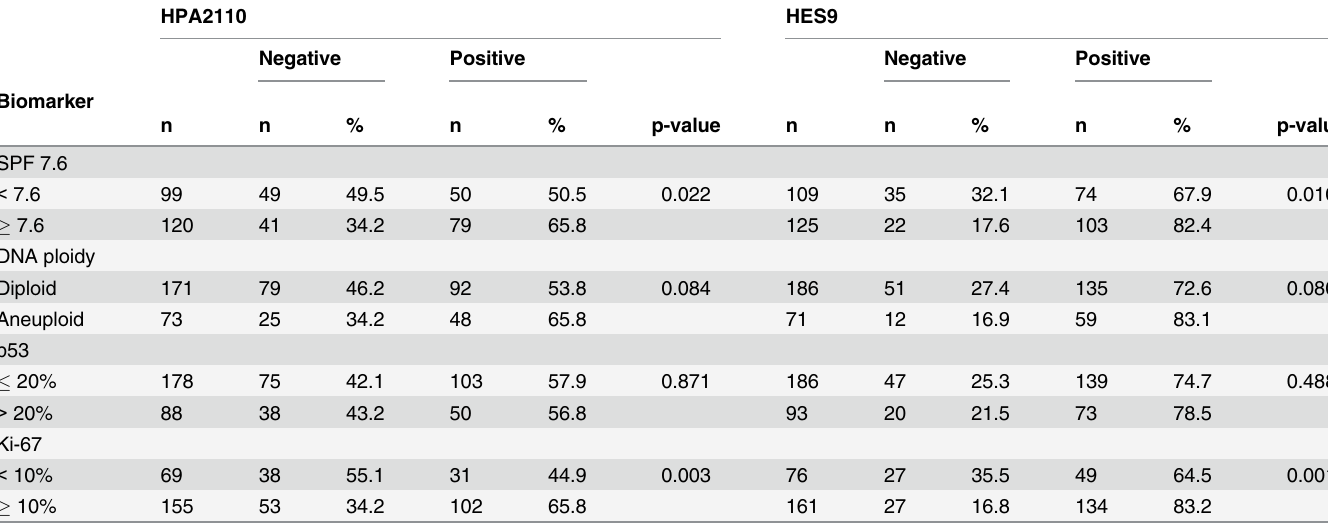
Table 2. Association of HPA2110 and HES9 with molecular biomarkers in gastric cancer patients.